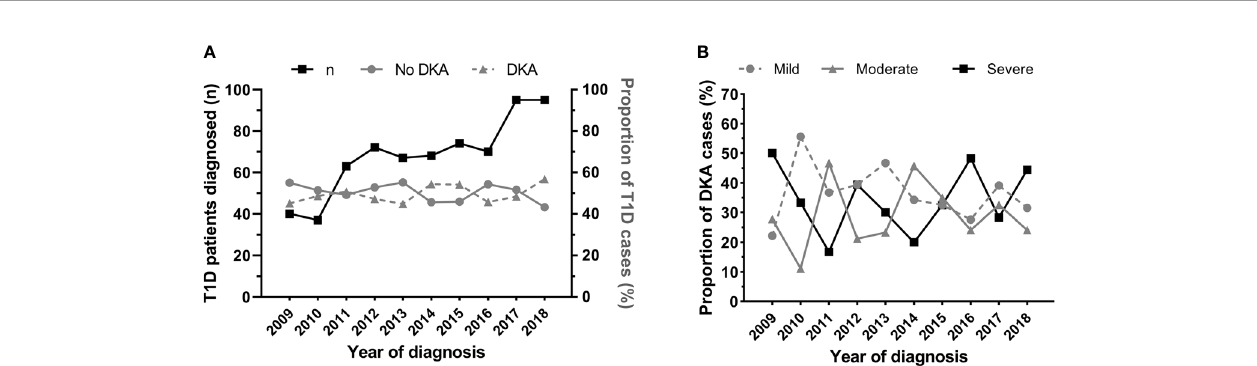
FIGURE 1 | Number of patients aged <16 years newly diagnosed with type 1 diabetes (T1D) at the Children ’ s Hospital of Zhejiang University School of Medicine (Hangzhou, China) in 2009-2018, and rates of diabetic ketoacidosis (DKA) at diagnosis. (A) Number of patients newly diagnosed with T1D (black line, scale on left y axis) and the respective rate of DKA (solid grey line, scale on right y axis) and no-DKA (dashed grey line, scale on right y axis) at diagnosis. (B) Proportion of patients with mild (dashed grey line), moderate (solid grey line), and severe (black line) DKA at T1D